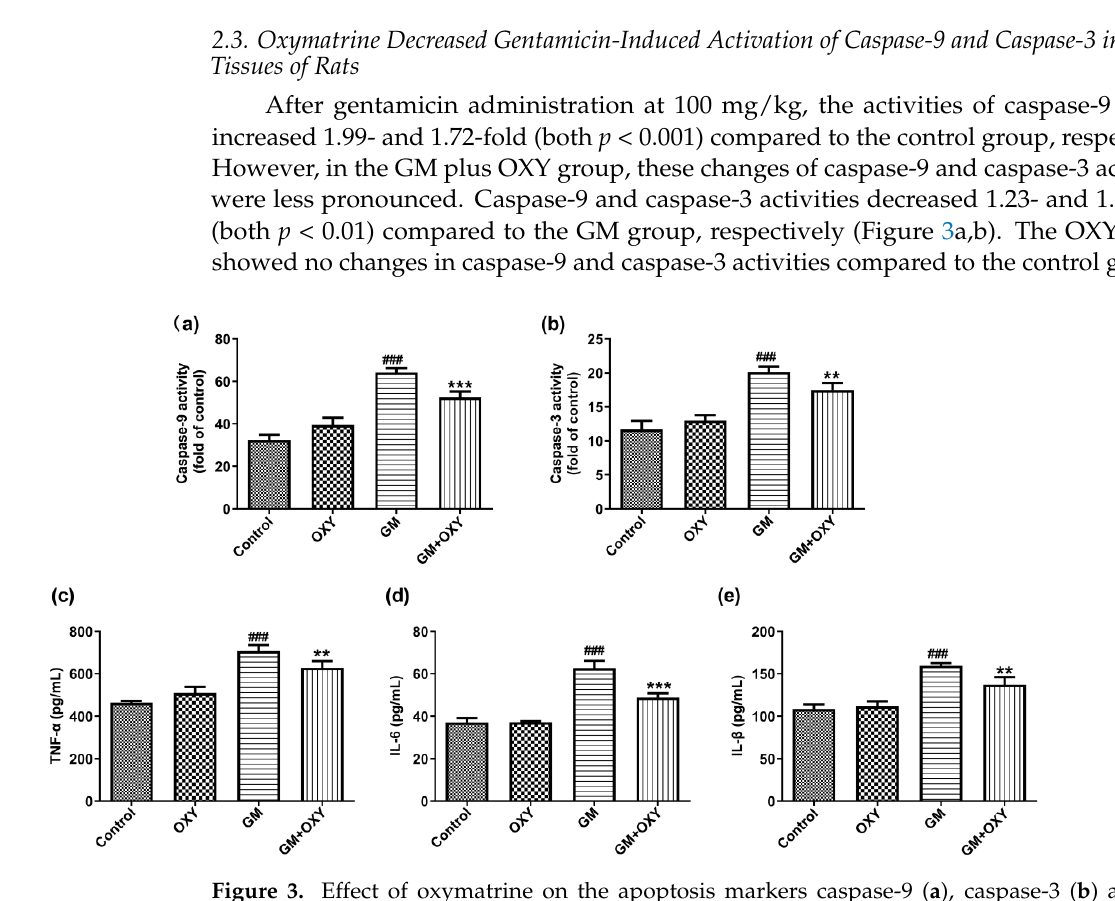
Figure 3. Effect of oxymatrine on the apoptosis markers caspase-9 ( a ), caspase-3 ( b ) and pro-inflam- matory markers TNF- α ( c ), IL-6 ( d ) and IL-1 β ( e ) in the serum of rats treated with gentamicin. ELISA results are presented as the mean ± SD ( n = 10). ### p < 0.001 compared to the control group; ** p < 0.01 and *** p < 0.001compared to the solely GM treatment